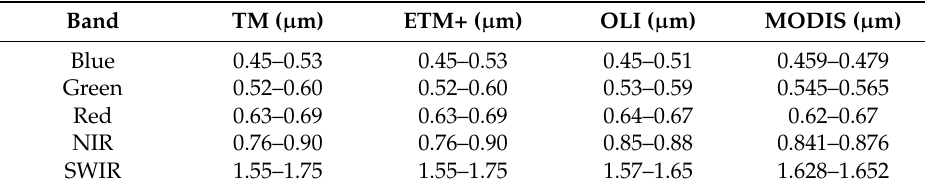
Table 1. The comparison of band wavelengths between Landsat and